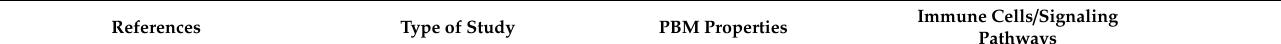
E ff ect of laser at peripheral blood lymphocyte subsets